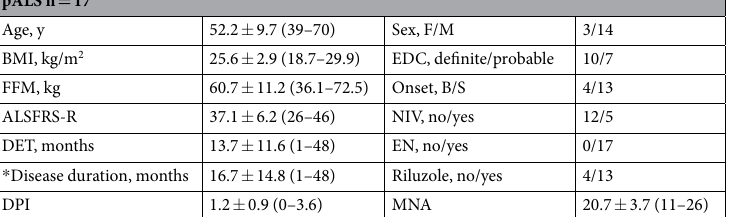
Table 1. Demographic and clinical characteristics of patients with amyotrophic lateral sclerosis (pALS). B = bulbar or S = spinal onset; BMI = body mass index; DET = diagnosis elapsed time (from disease onset); DPI = disease progression index; EDC = El Escorial diagnosis category; EN = enteral nutrition; FFM = fat free mass; ALSFRS-R = ALS Functional Rating Scale-Revised; MNA = mini nutritional assessment index; NIV = non-invasive ventilation. * From the diagnosis to study start. Data are shown as mean ± SD